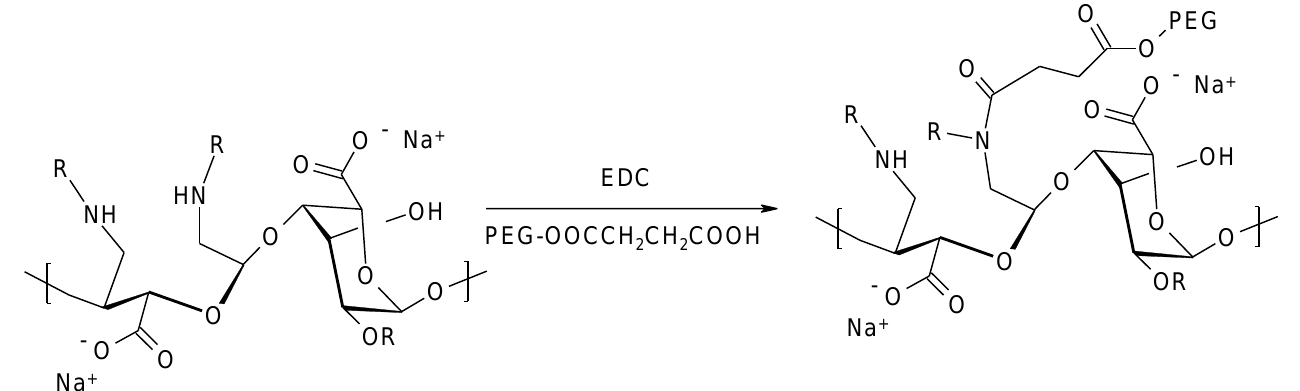
Figure 13. Synthesis of PEG-ylated alginate derivative.